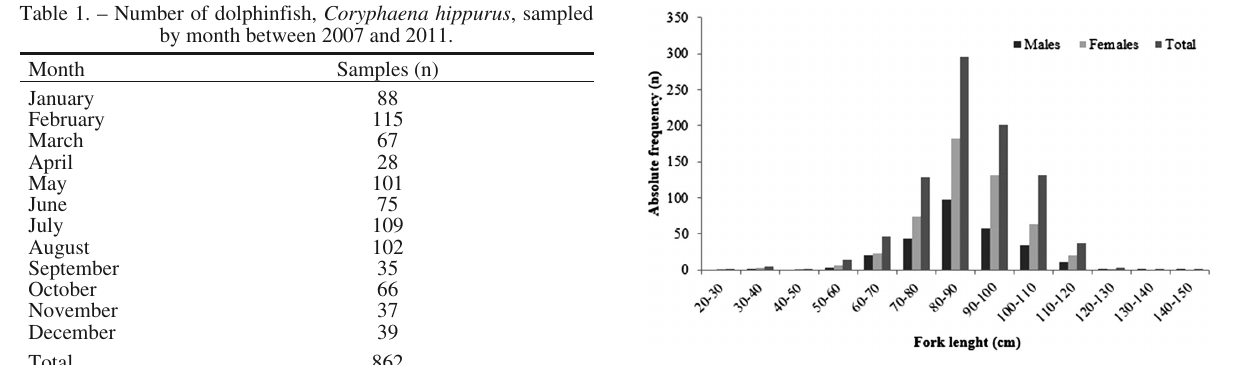
Fig. 2. – Frequency distribution of fork length of specimens of dol- phinfish, Coryphaena hippurus , caught in the vicinity of the Saint